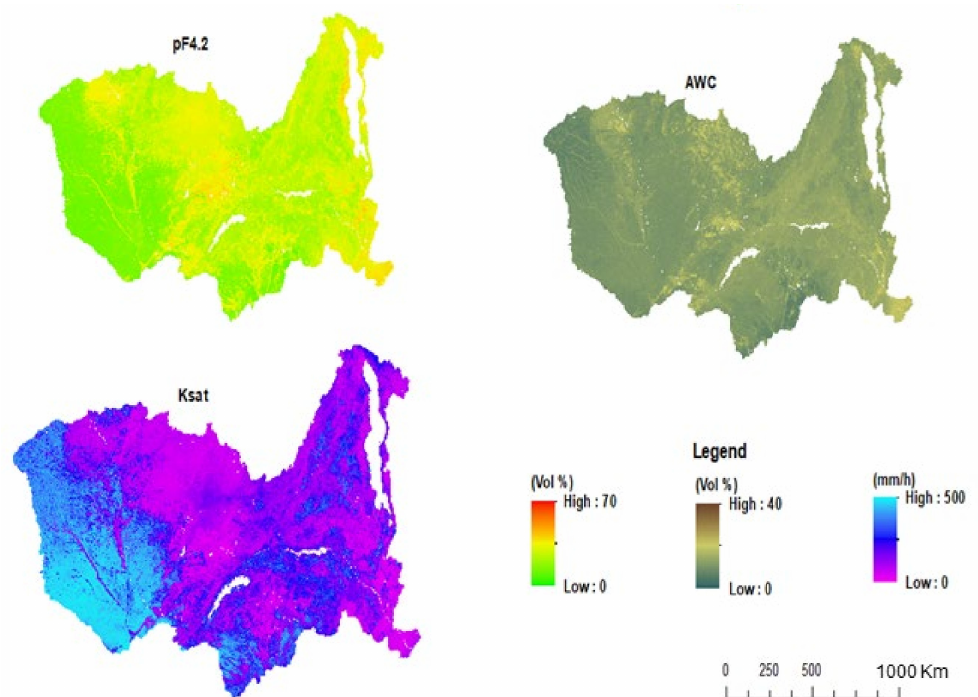
Figure 9. Soil hydraulic properties at 30 cm depth for the Zambezi River Basin. The data has a spatial resolution of 90 m, and the maps were generated using a random forest regression model based on legacy soil data, complemented with own field data, and environmental covariates reflecting soil classes, climate, landcover, relief, and